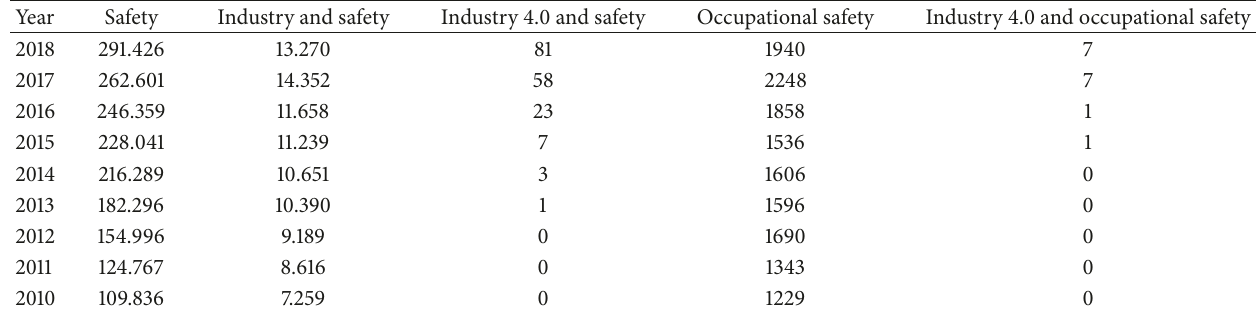
Table 3: Number of scientific publications on safety and occupational safety in the Industry 4.0 (Results from the Web of Science. Timespan: 2010-2018; All databases; Field tag: